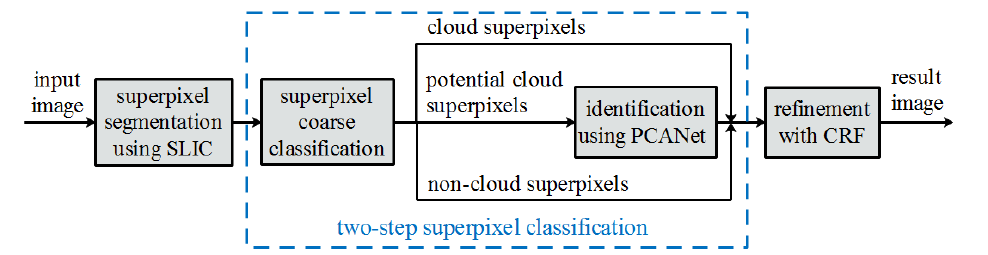
Figure 1. Flow chart of the proposed cloud detection